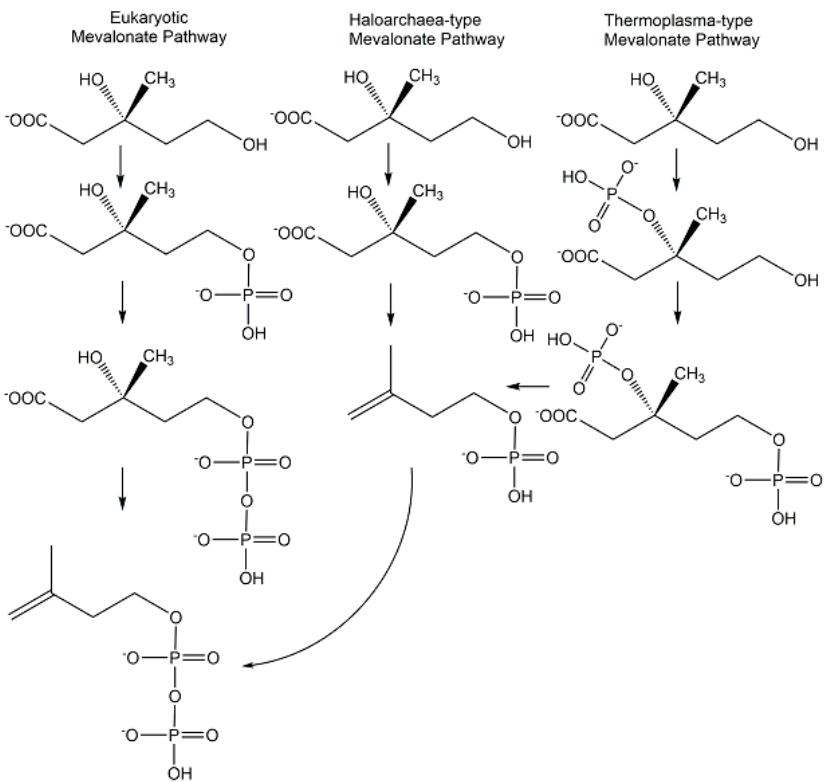
Figure 14. Phosphometabolites of the Eukaryotic, Haloarchaea-type, and Thermoplasma-type mevalonate pathways.